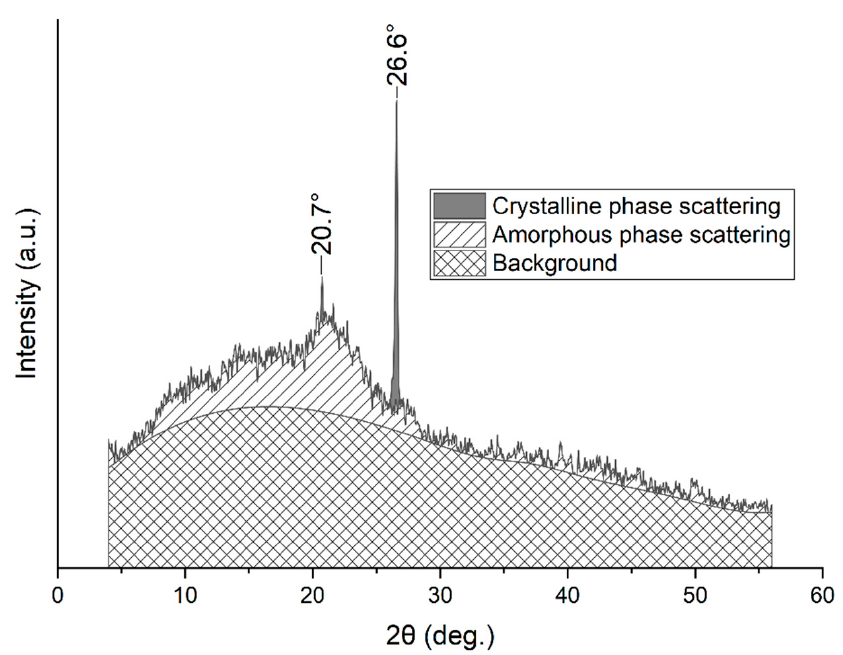
Figure 2. X-ray powder di ff ractogram of wheat straw powder